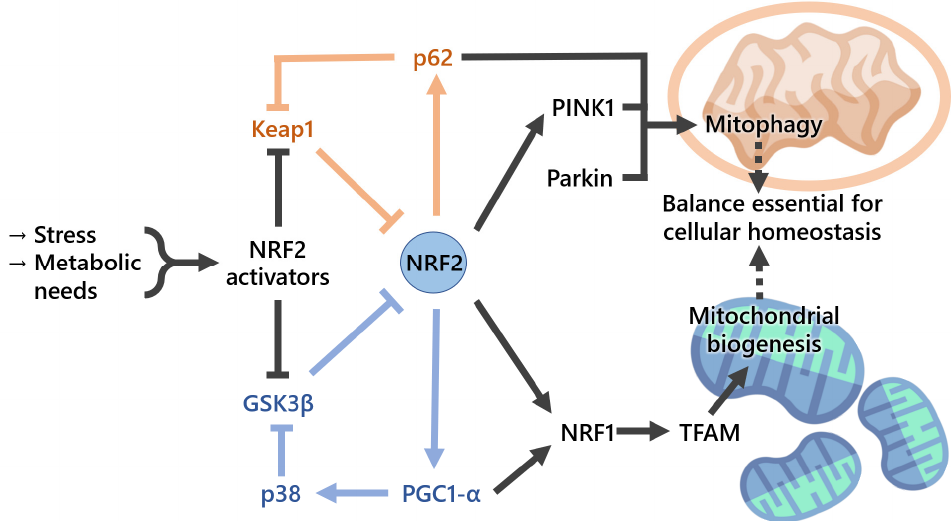
Figure 4. NRF2 plays an important role in mitochondrial and cellular homeostasis. Simplified representation of mitophagy and mitochondrial biogenesis pathways mediated by p62 and PGC1- α , respectively, upon activation by NRF2, evidencing the regulatory loop involving p62, KEAP1, and NRF2 (orange), correlated with mitophagy, and the regulatory loop involving PGC1- α , p38, GSK3 β , and NRF2 (blue), associated with mitochondrial biogenesis. NRF2 activators include native proteins, such as AKT, but also xenobiotics, such as RTA-408 or sulforaphane, with the potential to be used in therapeutic strategies.